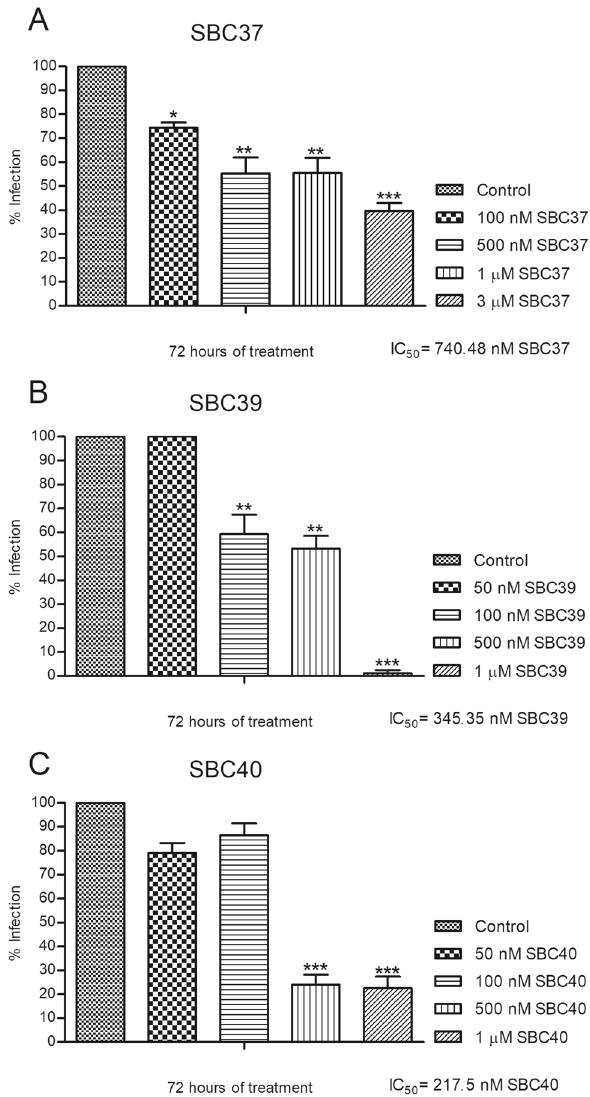
Figure 5. Evaluation of antiproliferative effects of SBC 37, SBC 39, and SBC 40 on Leishmania amazonensis intracellular amastigotes. Parasites were treated with different concentrations of the inhibitors for 72 h to evaluate the parasite growth. After 72 h of treatment, the IC 50 was determined for each inhibitor tested, and the values were 740.48 nM, 345.35 nM, and 217.5 nM, respectively. Thus, the selectivity index obtained was 45.83, 117.7, and 180, respectively. Bars represent standard deviation; * p < 0.05, ** p < 0.01, and *** p <